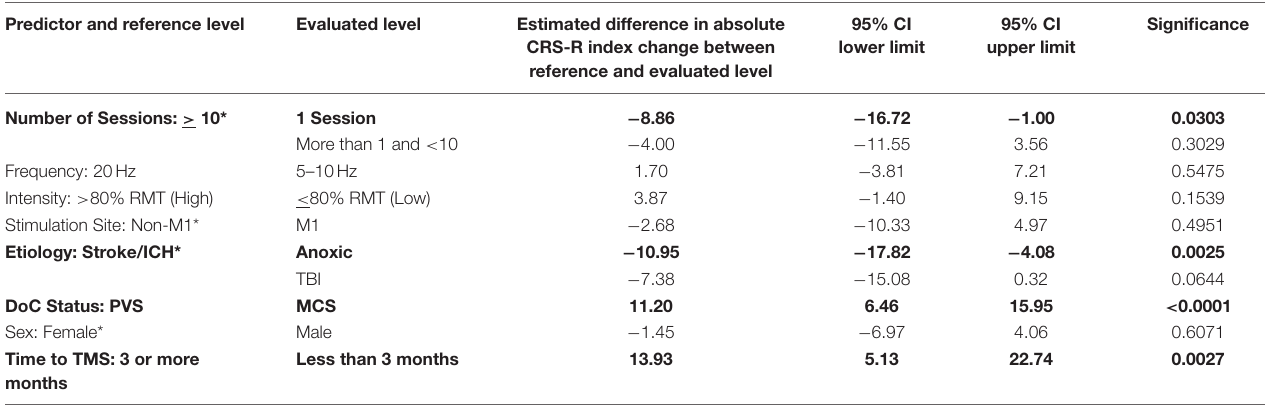
TABLE 5 | Results of univariate analysis: significance of predictors for absolute CRS-R index change.